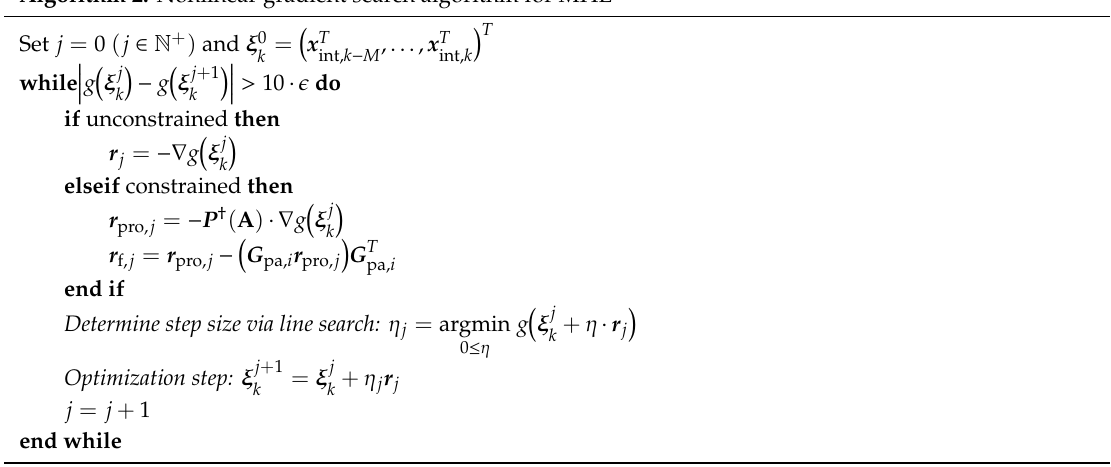
Algorithm 2. Nonlinear gradient search algorithm for